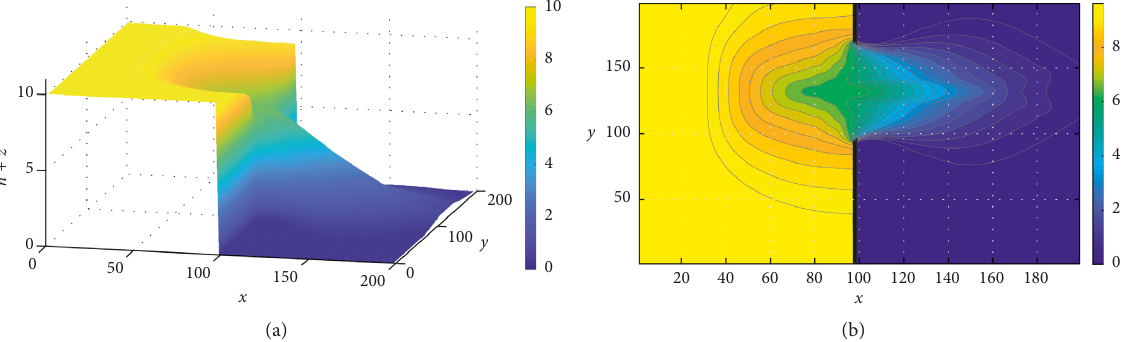
Figure 10: Water level (a) and its contour plot of h (b) of the dry bed partial dam-break problem at 7.2 s.